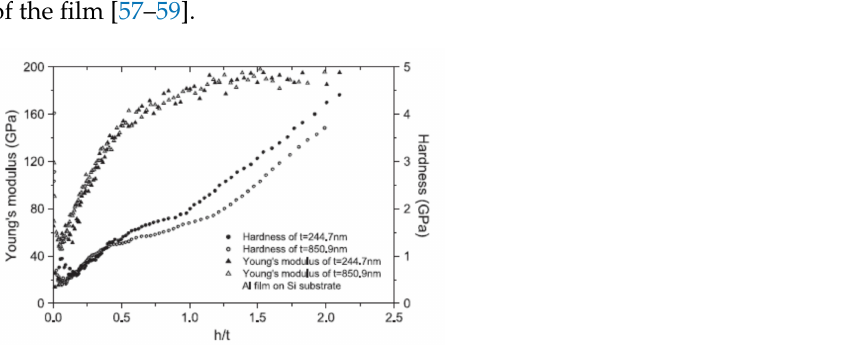
Figure 10. Hardness and Young’s modulus versus normalized indentation depth. Reproduced with permission from Ref.